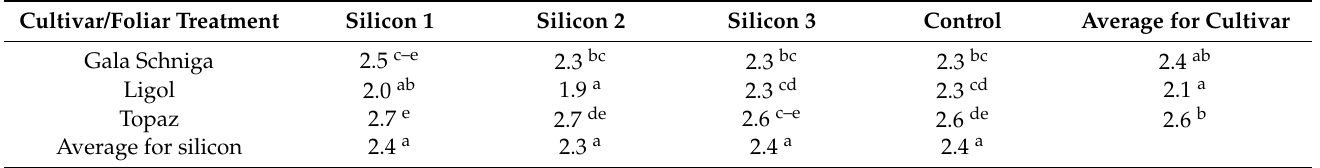
Table 2. The height of apple trees depends on cultivar and foliar silicon treatment (m).